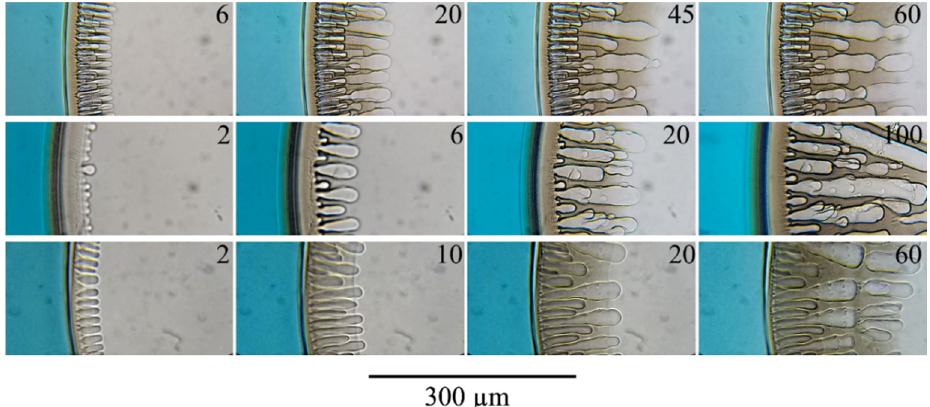
Figure 8. The evolution of the structure of a mixture of 15 wt.% PAN with DMSO/Acetone ratio 90/10 (Composition 2 from Table 1)—upper row; DMSO/Acetone ratio 50/50 (composition 3)—middle row; 20% PAN with DMSO (composition 4)—the bottom row. The time in seconds from the moment of contact between the sample and the non-solvent is indicated in the upper right corner of each photo.